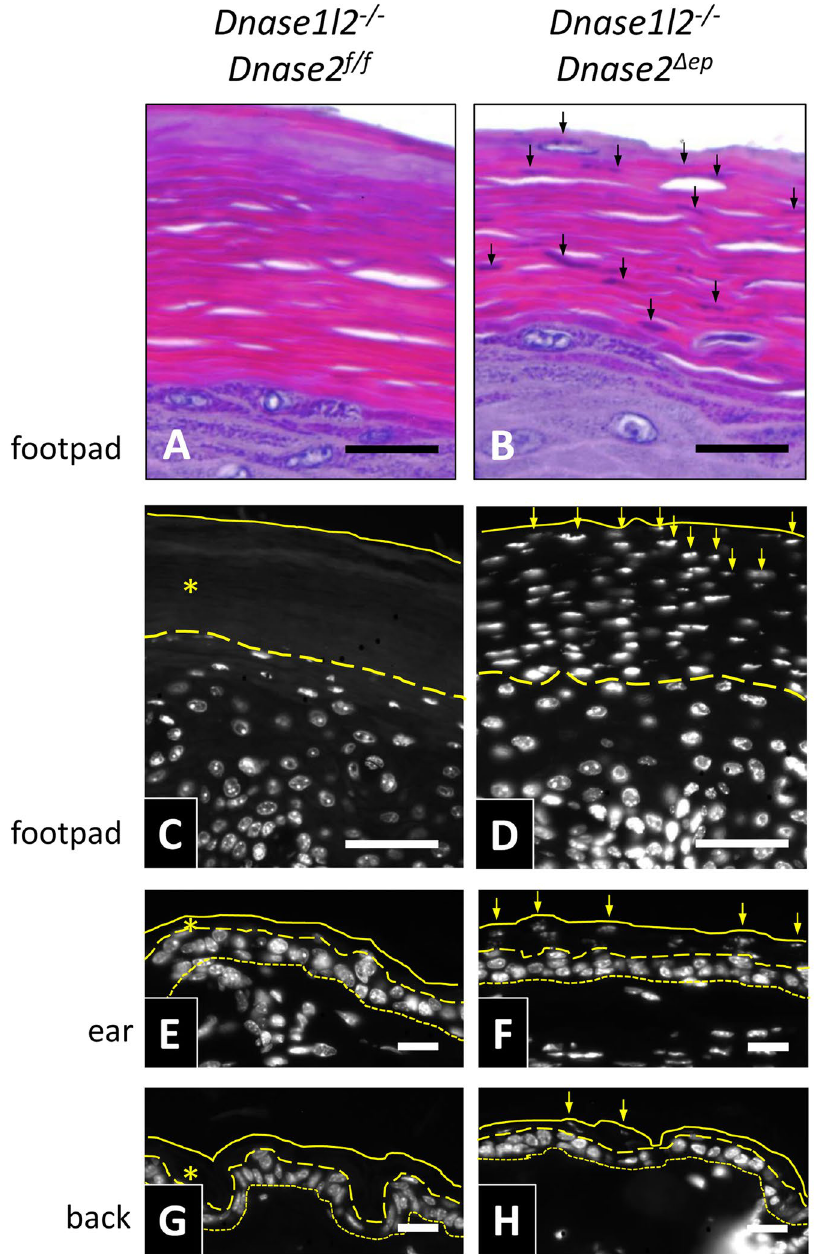
Figure 1. DNase1L2/DNase2 double knockout causes parakeratosis. Thin section of the skin from Dnase1l2 − / − ( A , C , E , G ) and Dnase1l2 − / − Dnase2 Δ ep ( B , D , F , H ) mice were stained with hematoxylin and eosin ( H and E ) ( A , B ) and the DNA-specific dye Hoechst 33258 ( C – H ). The skin was prepared from the footpads ( A , D ), ears ( E , F ), and back ( G , H ). Continuous and dashes lines indicate the outer and the inner border of the stratum corneum, respectively. The basal layer of the epidermis is indicated by dotted lines. Arrows indicate nuclear remnants detected in terminally differentiated corneocytes of Dnase2 ∆ ep mice. The data are representative of at least 3 mice per genotype. Scale bars, 20 µ